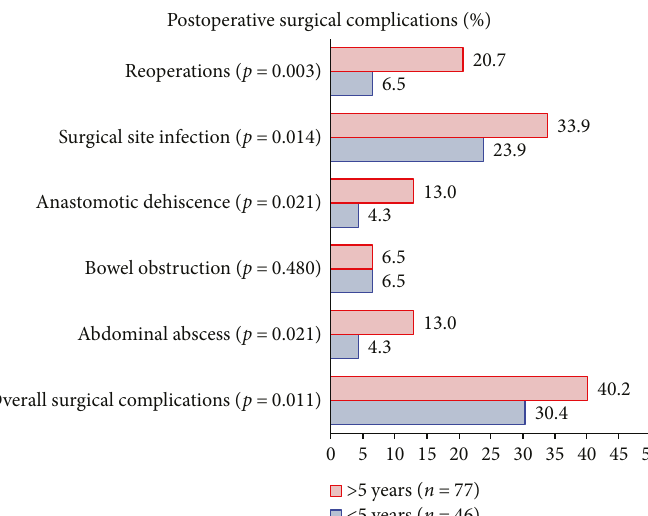
Figure 1: Postoperative surgical complications between the groups. Higher prevalence of reoperations, surgical site infection, anastomotic dehiscence, abdominal abscess, and overall complications were observed in patients with TS > 5 years. No di ff erence was observed in bowel obstruction.